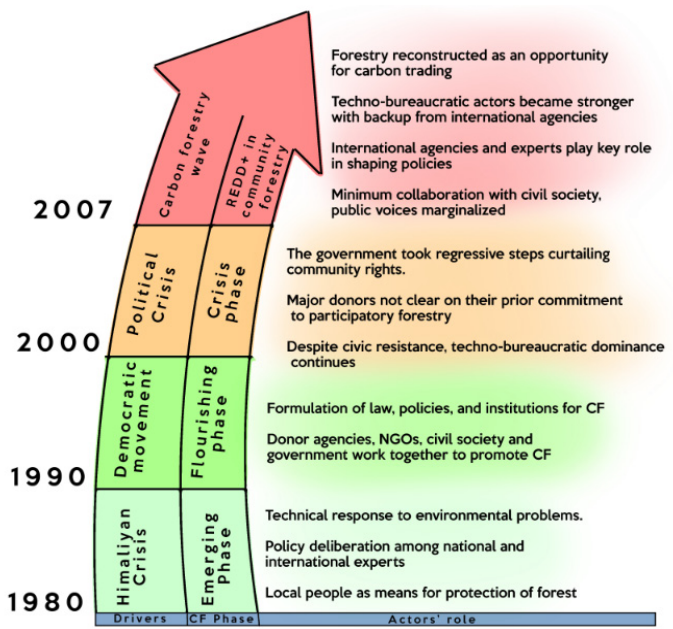
Figure 2. Drivers of paradigm shift and actors’ roles in different phases of community forestry. (Source: Authors’ own illustration based on own data analysis).